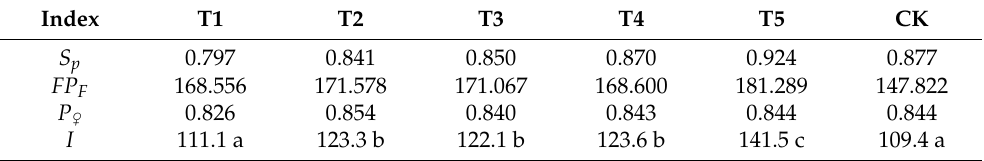
Table 2. The index of population trend of T. dendrolimi terminated diapause of five selected